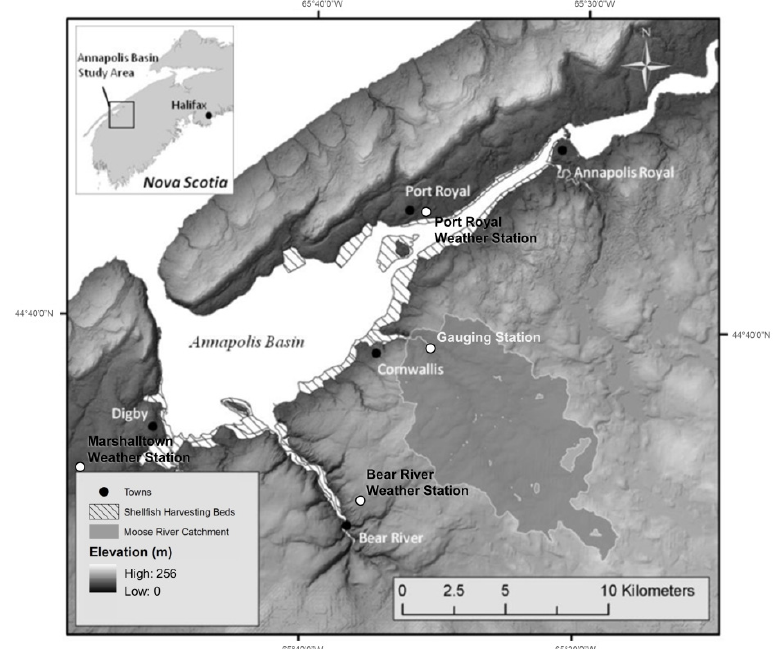
Figure 1. Annapolis Basin study area with Moose River catchment. Gauging station is located above tidal